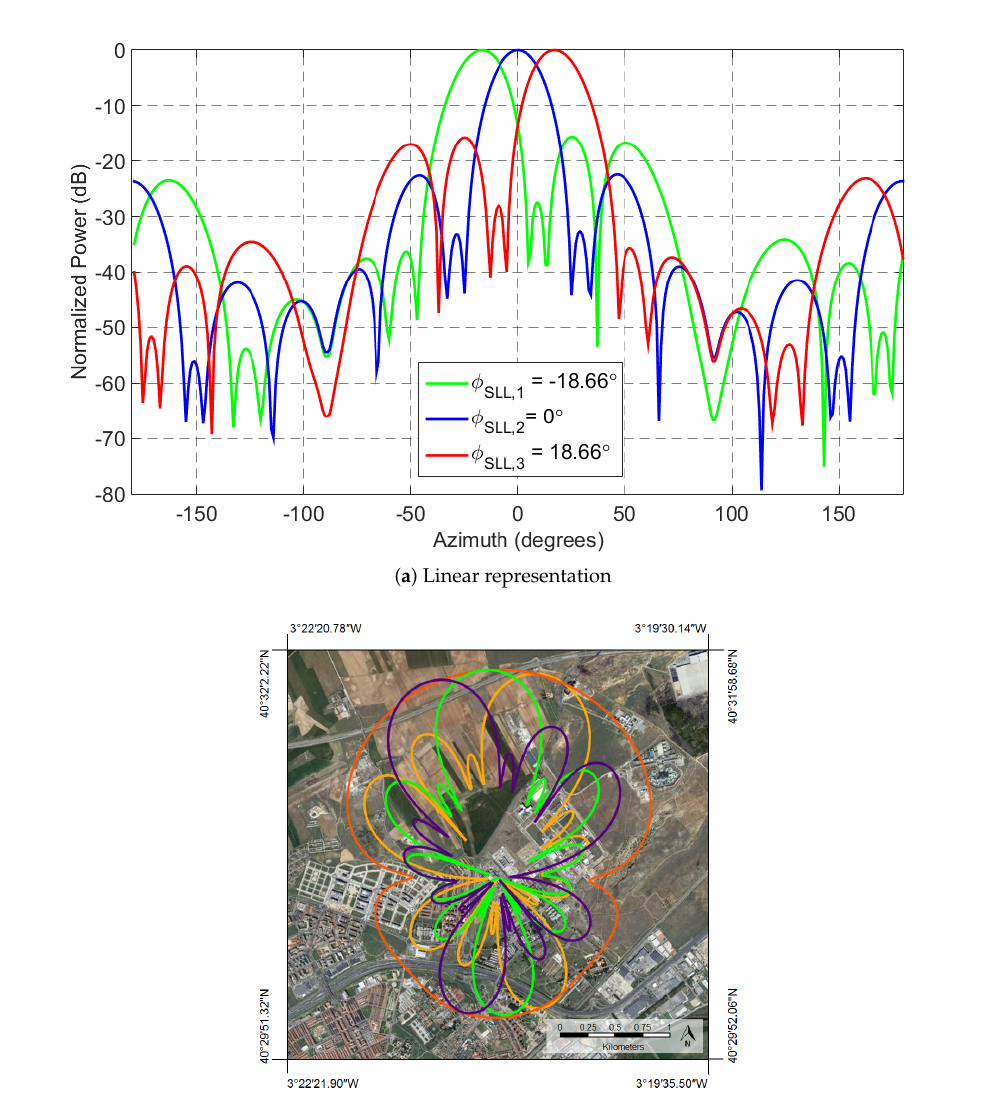
Figure 17. Azimuth radiation pattern of NULA multiple simultaneous orthogonal beams in the azimuth coverage area φ ∈ [ − 30 ◦ , − 30 ◦ ]